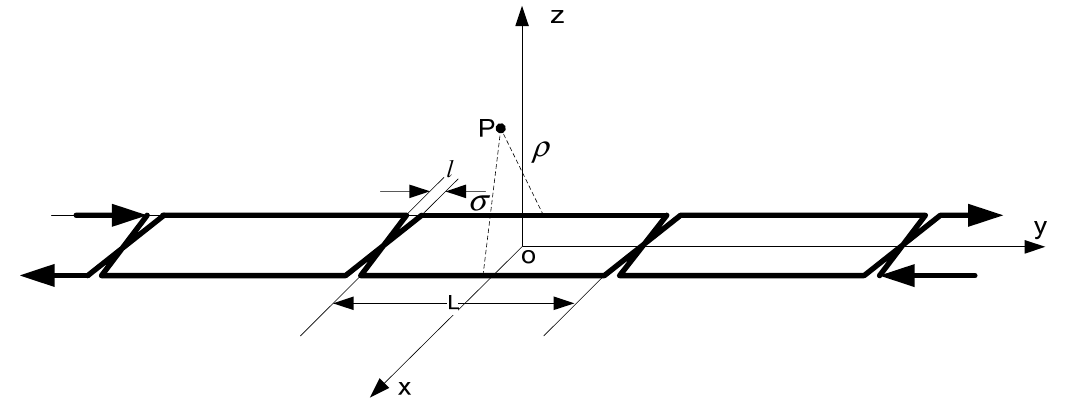
Figure 13. Equivalent model of loop-cable with